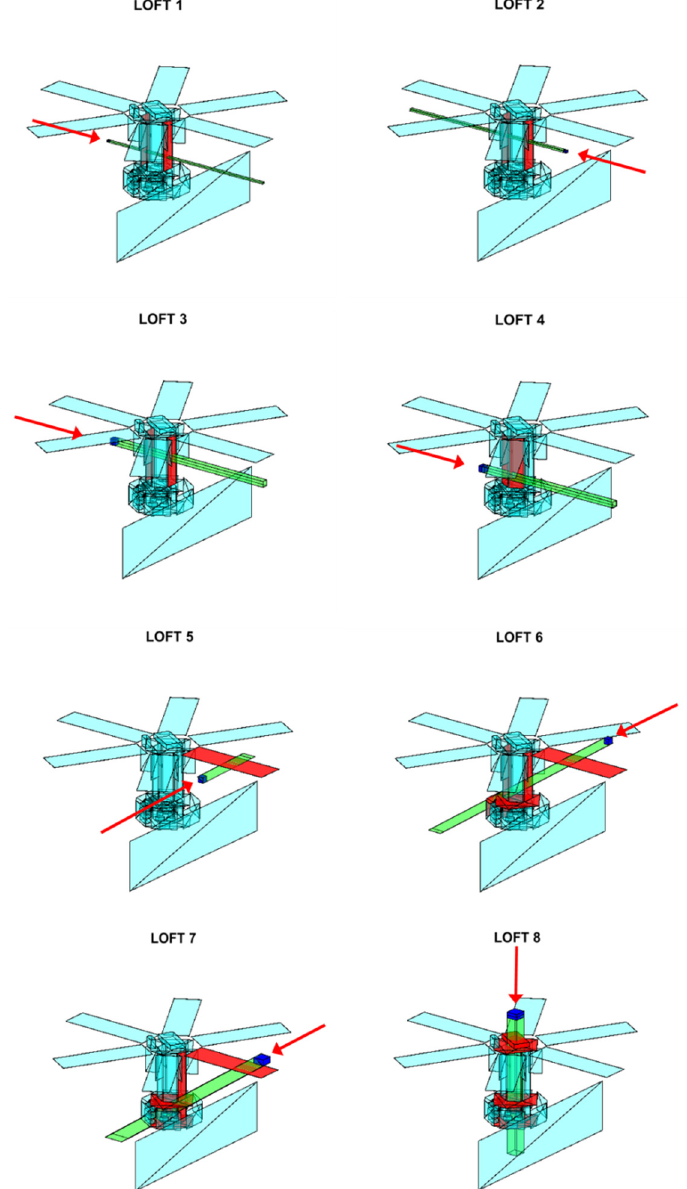
Figure 13. Collision configurations for the LOFT simulation campaign. The arrows indicate the impactors and the velocity vector, and the impactors cross-section is extruded along the velocity vector to show the nominal path through the target [52].